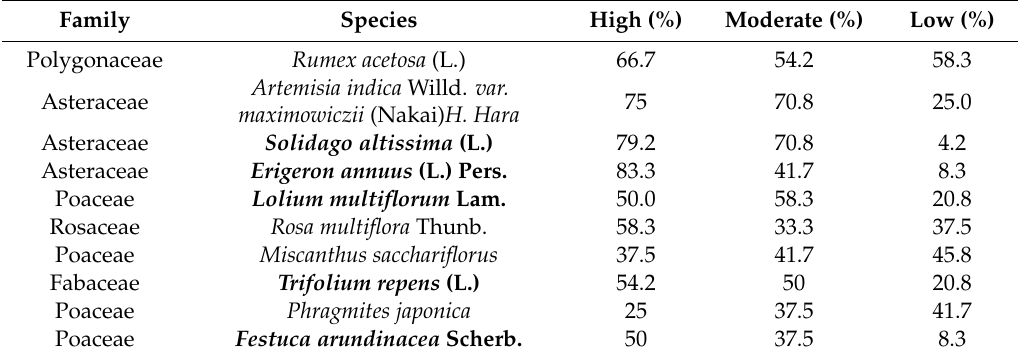
Table 3. The top 10 most frequent plant species found in floodplain area. Plant species were ranked by frequency of occurrence in all sampling plots ( n = 72 plots). Notes: species in bold indicate non-native species.